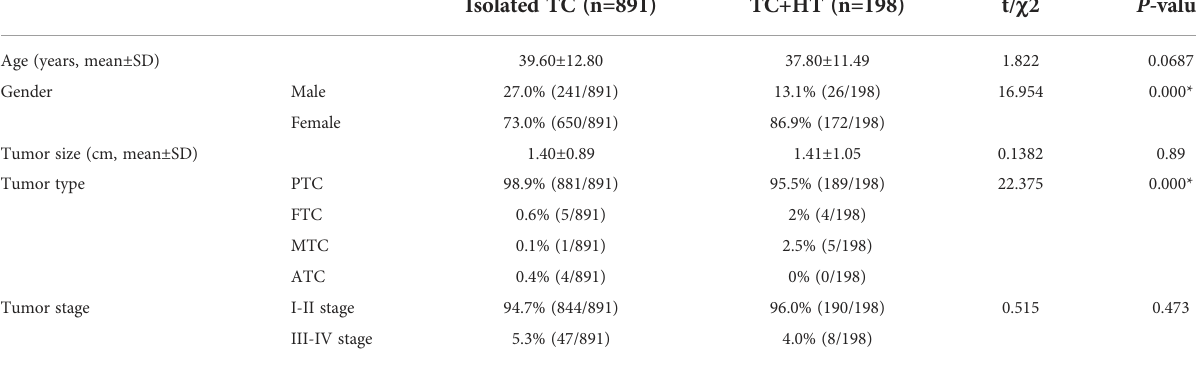
TABLE 3 Patient Characteristics of isolated TC and TC with HT.